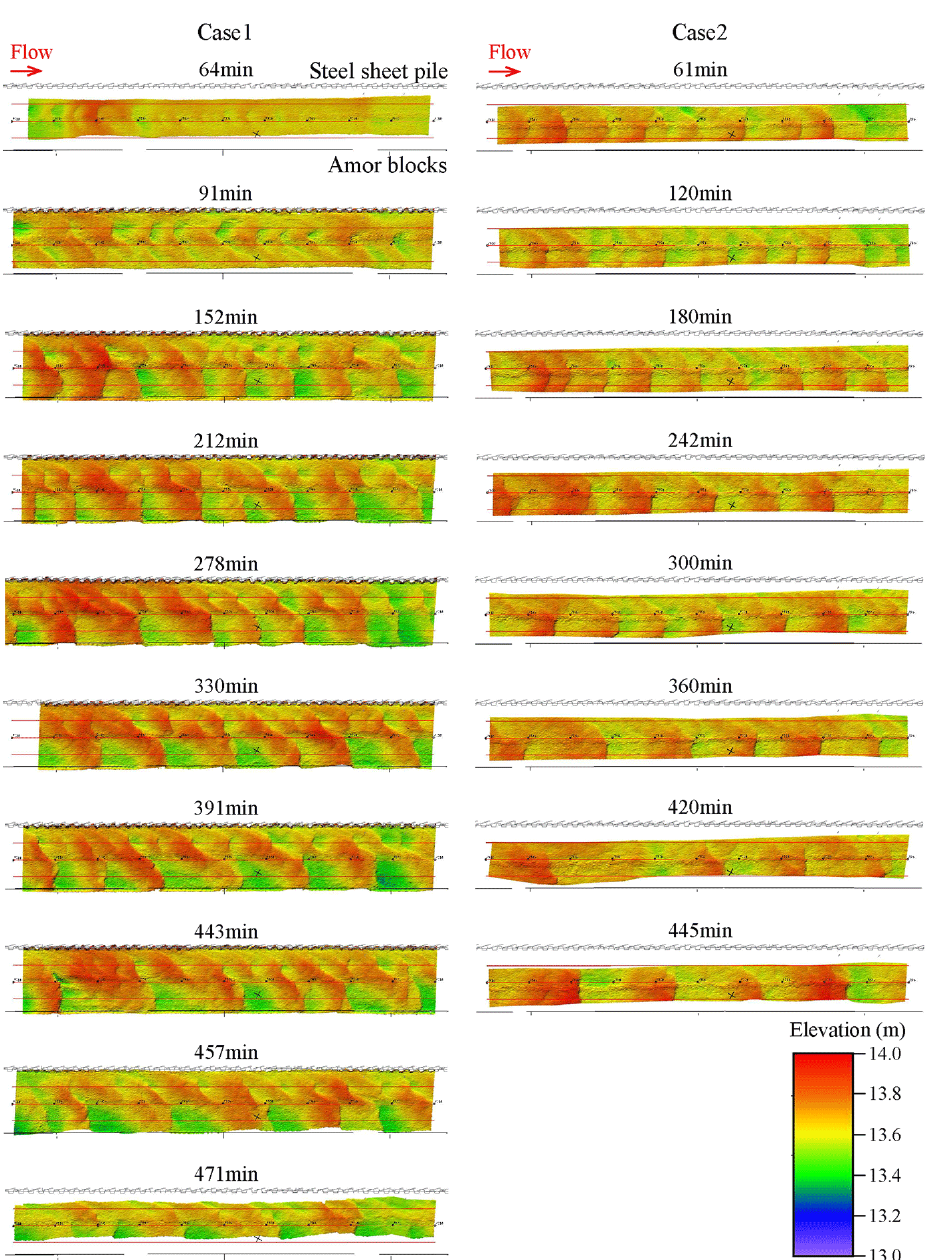
Fig. 3. Contour maps of bed elevation. Left: Case 1, right: Case